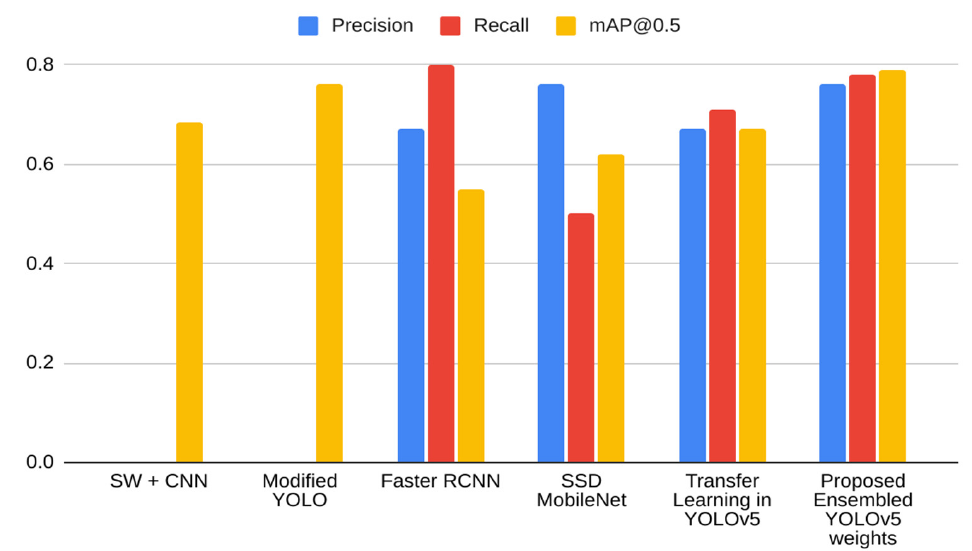
Figure 8. Result comparison of different object detection models. The ground truth image in Figure 9 is the actual image with the annotation in the test set, and the predicted result image is generated by the model when the test image is passed without annotations. The actual result of the image has 11 infected cells, and the proposed model was able to detect 10 of them successfully and provided one false-positive result.